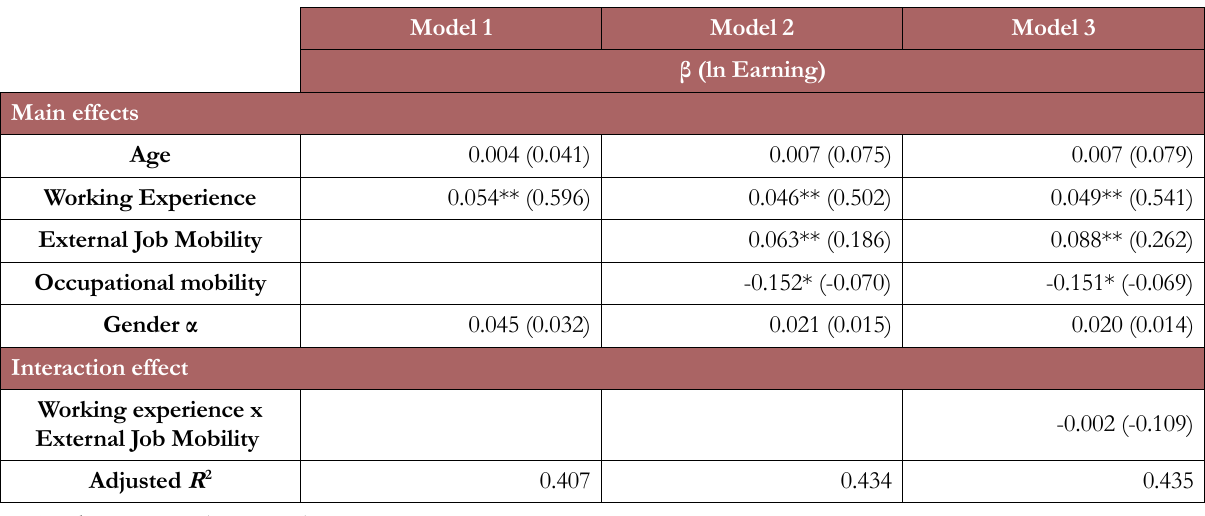
Table 3. Multiple regression analysis of study variables on